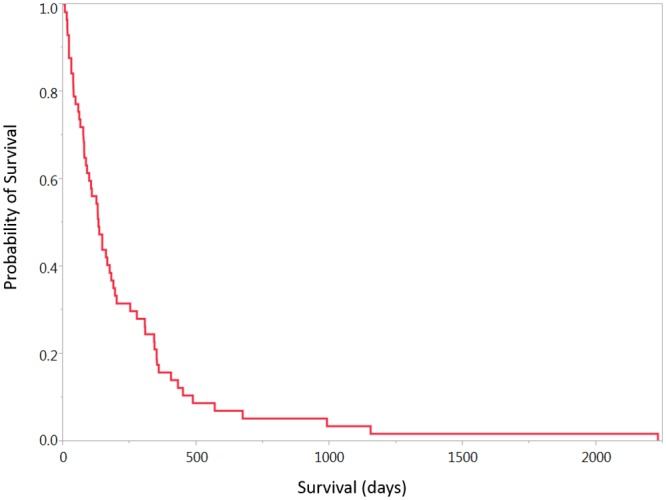
Overall survival curve.